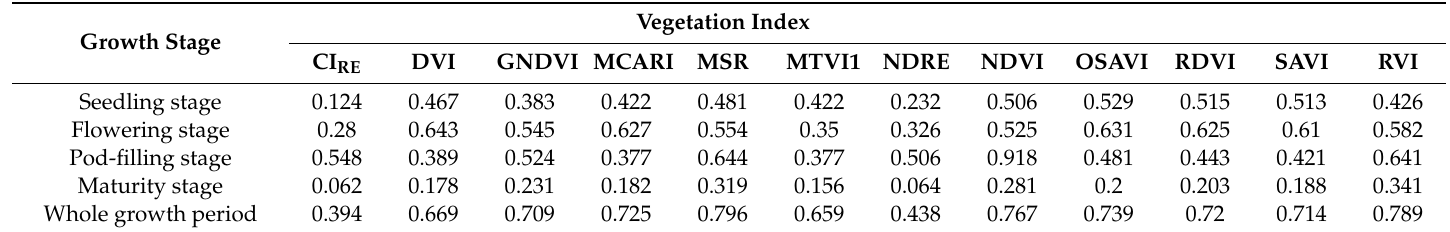
Table 3. Correlations between the vegetation indices and peanut leaf area index (LAI) at each growth